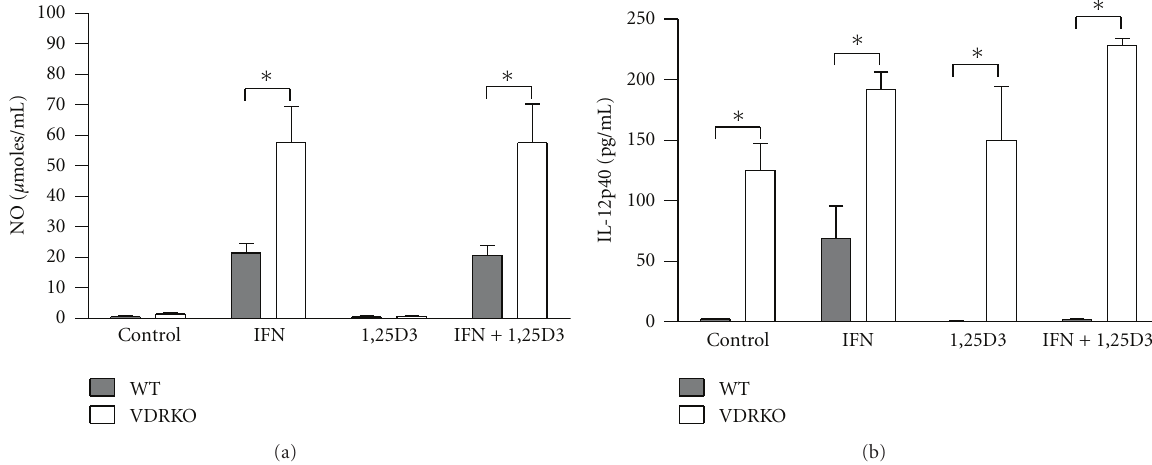
Figure 7: NO and IL-12p40 production by host cells. C57BL/6 WT (closed bars) and VDRKO (open bars) mice. DC were treated with IFN γ and/or 1,25D3 for 24 hr prior to being infected at a ratio of 5: 1 with L. major. The cells were infected for 4hr and washed to remove extracellular parasites. Supernatants were harvested 48 hr after infection and analyzed for production of NO (a) and IL-12p40 (b). Mean ± standard error is presented; ( n = 4). ∗ P ≤ 0 .